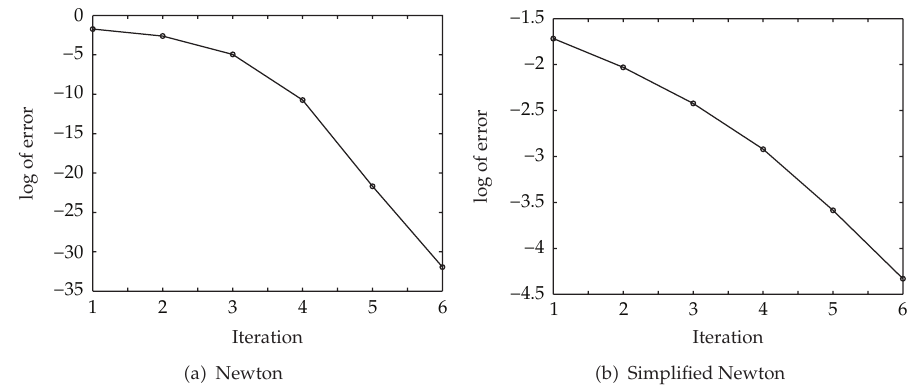
Figure 4: logmax n,m | B z (cid:2) n,m (cid:3) − B z (cid:2) n,m (cid:3) j | error